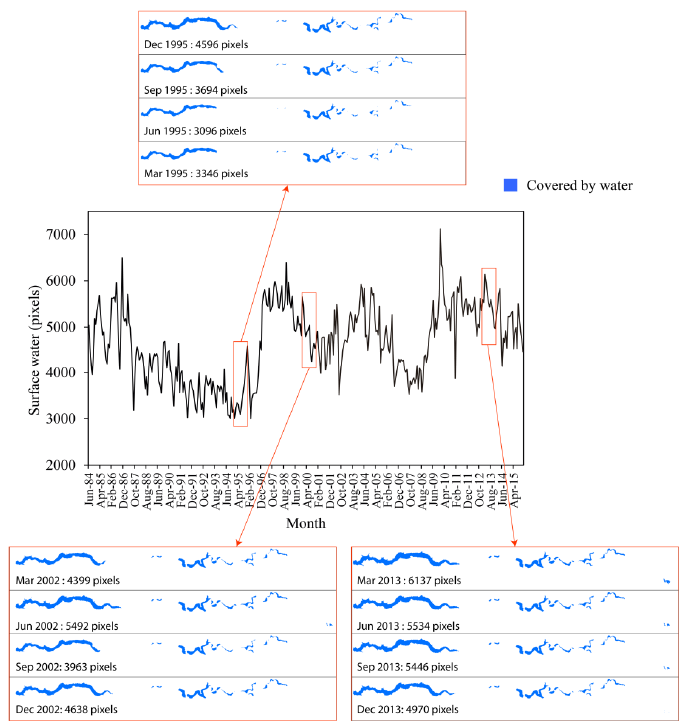
Figure 13. Monthly time series of the estimated surface water for the study period (1985–2015) and spatial distribution of the surface water for some months (March, June, September, and December) of a dry year (1995), an average year (2002), and a wet year (2013). The area used for the spatial representation is shown as a white square in Figure 1.